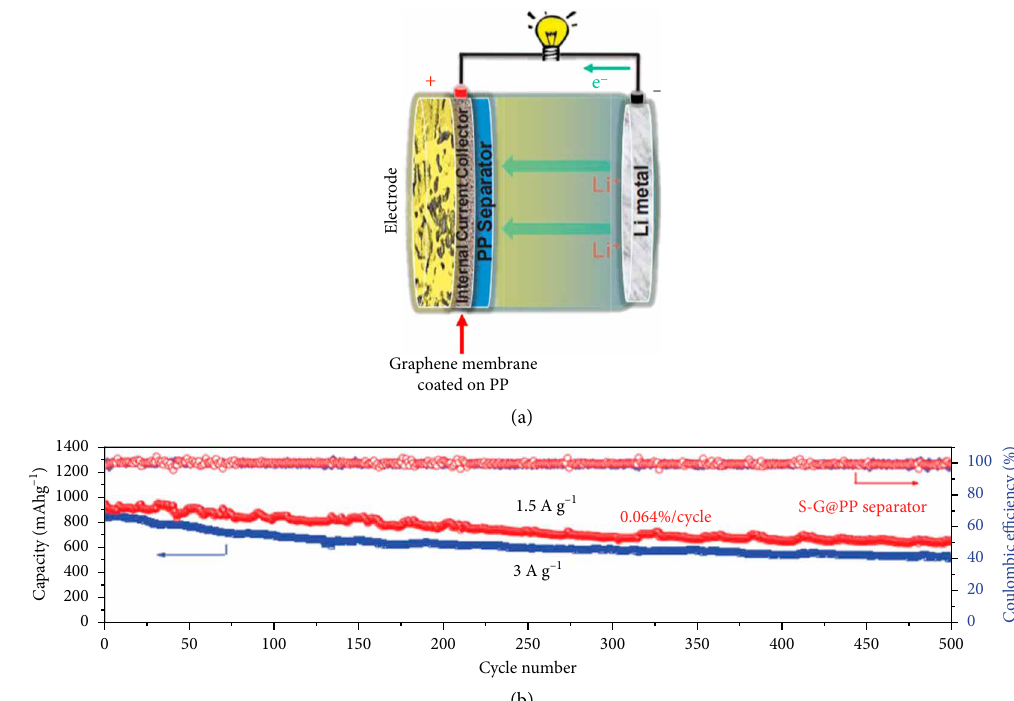
Figure 6: (a) Schematic illustration of electrode configuration with PP and graphene composite. (b) Cycle stability of graphene/PP separator at current density of 1.5 and 3 A g −1 . Adapted from